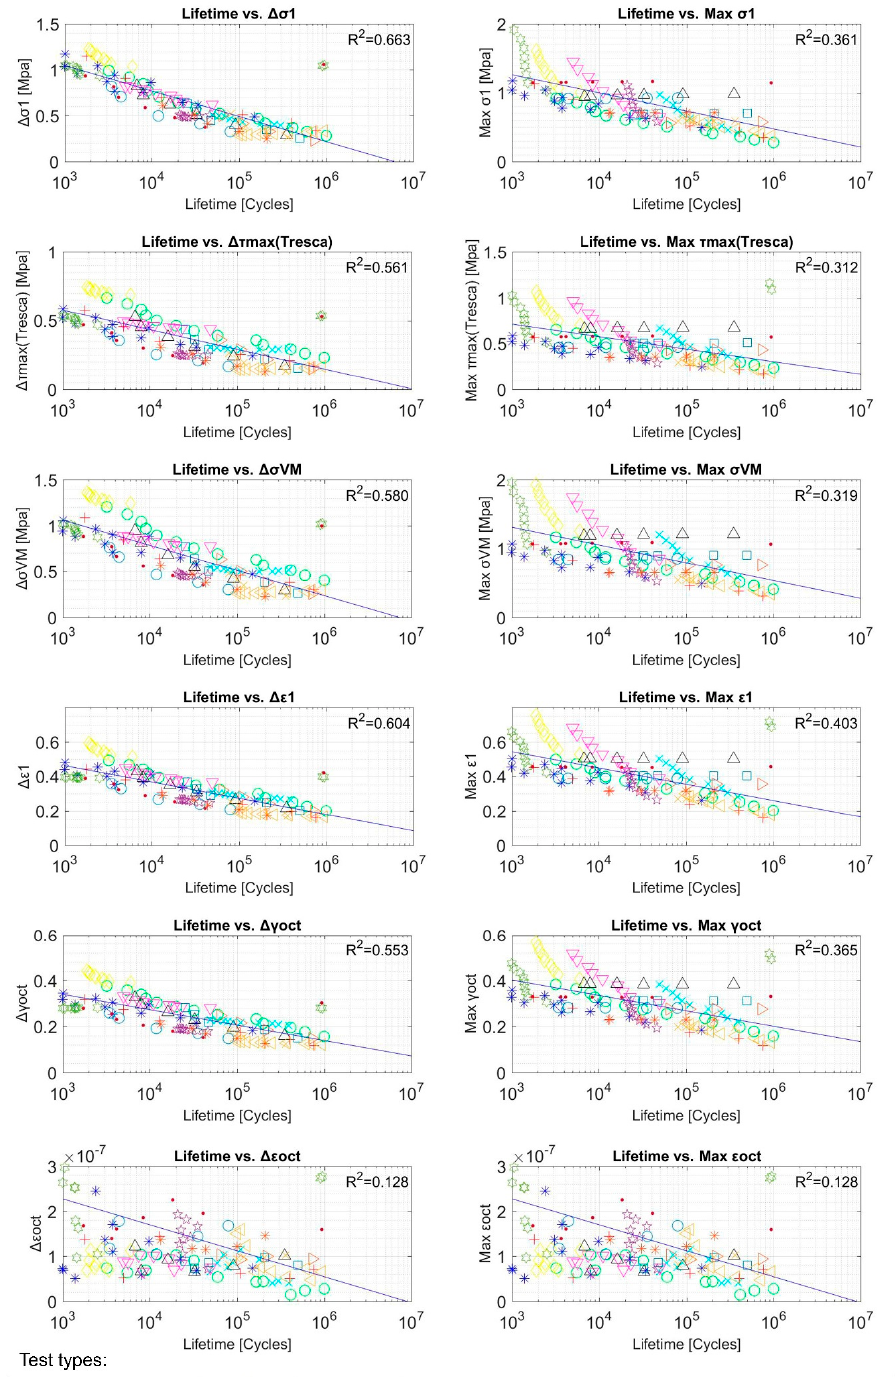
Figure 11. Fatigue parameters and tests lifetime (cycles) correlation for SBR tests. Initial data from Figure 11. Cont